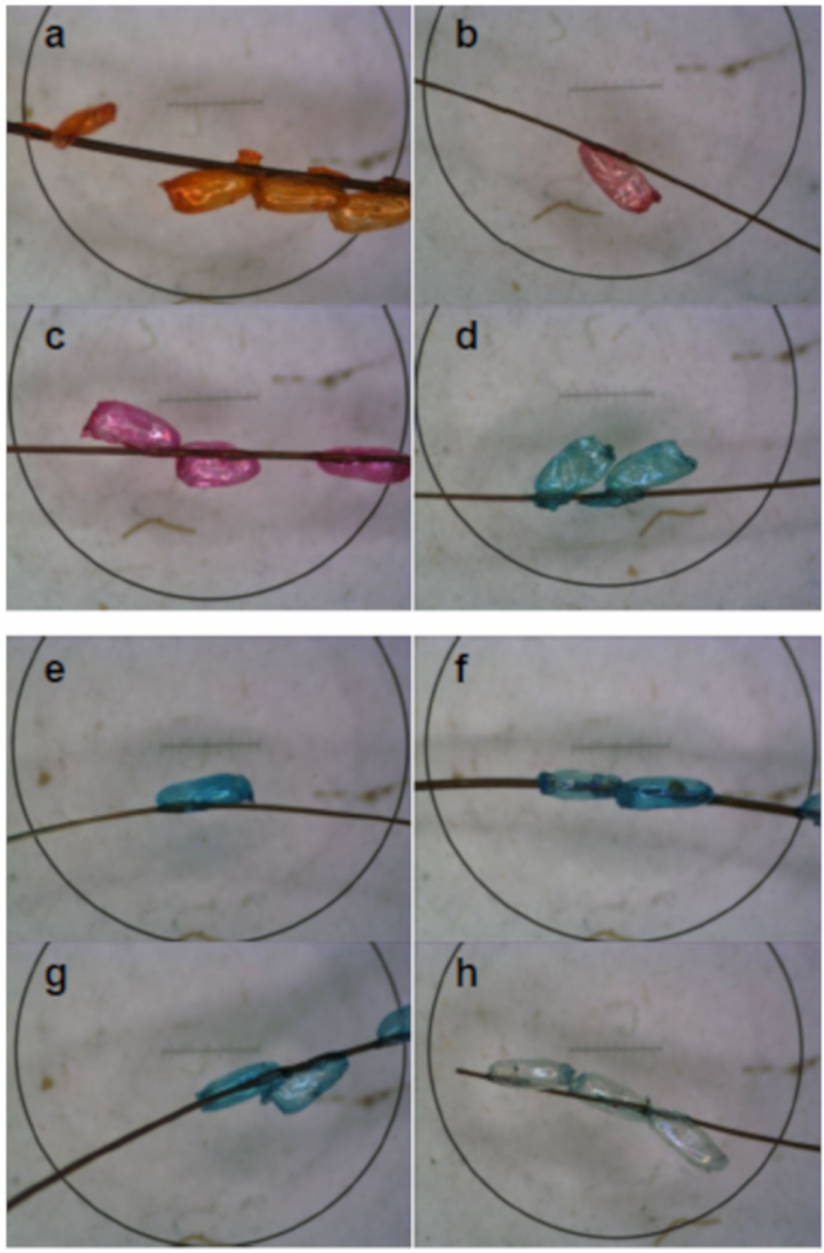
Figure 2. Staining e ff ect of di ff erent dyes on hatched eggshells (nits). ( a ) = Sunset Yellow 1.0%, ( b ) = Ponceau 4R 1.0%, ( c ) = Erythrosine 0.1%, ( d ) = Green S 0.1%, ( e ) = Patent Blue 1.0%, ( f ) = Brilliant Blue 1.0%, ( g ) = Patent Blue 0.1%, ( h ) = Brilliant Blue